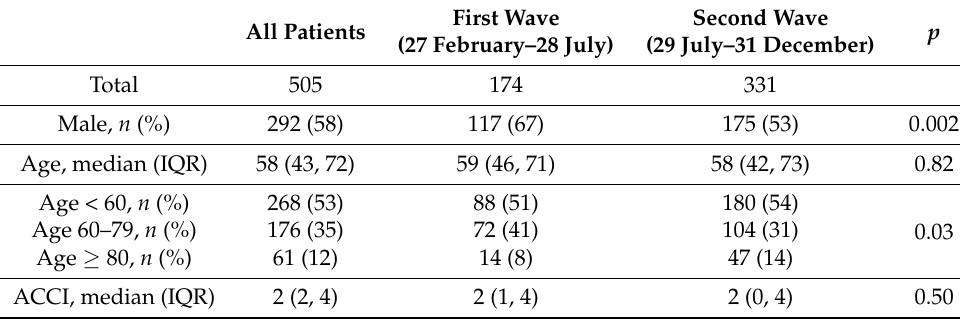
Table 1. Demographic information and